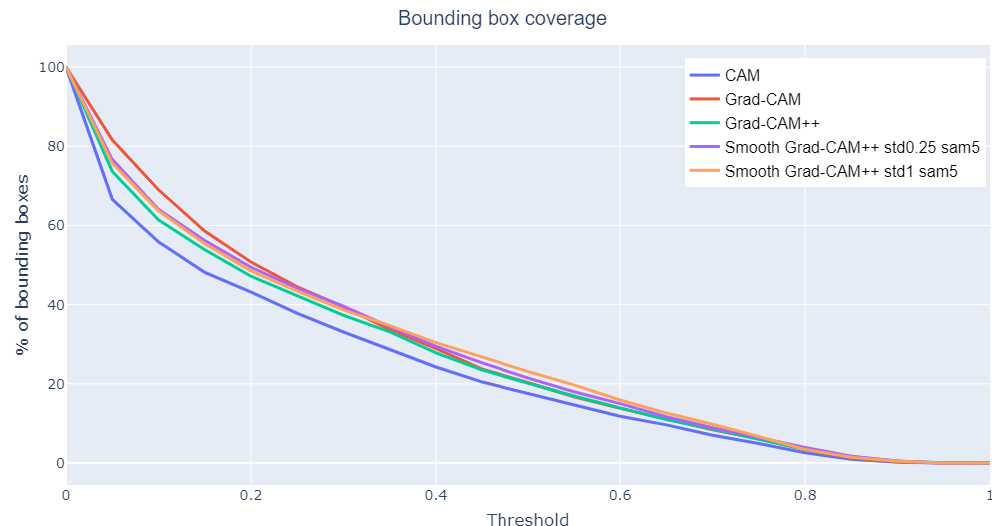
Figure 10. Bounding box coverage at varying threshold values.